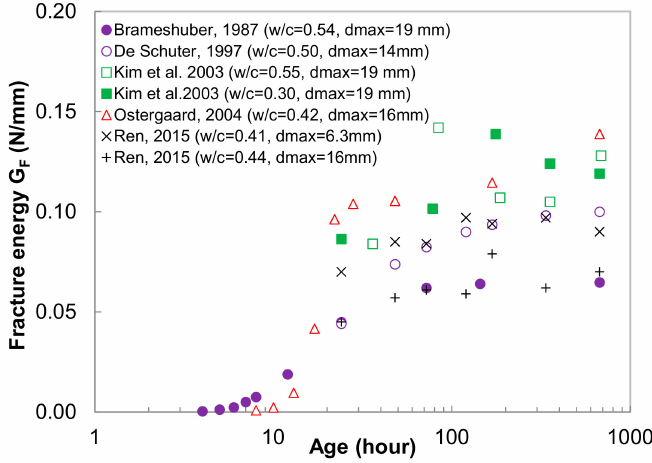
Figure 11. Summary of experimentally obtained early age concrete fracture energy for normal